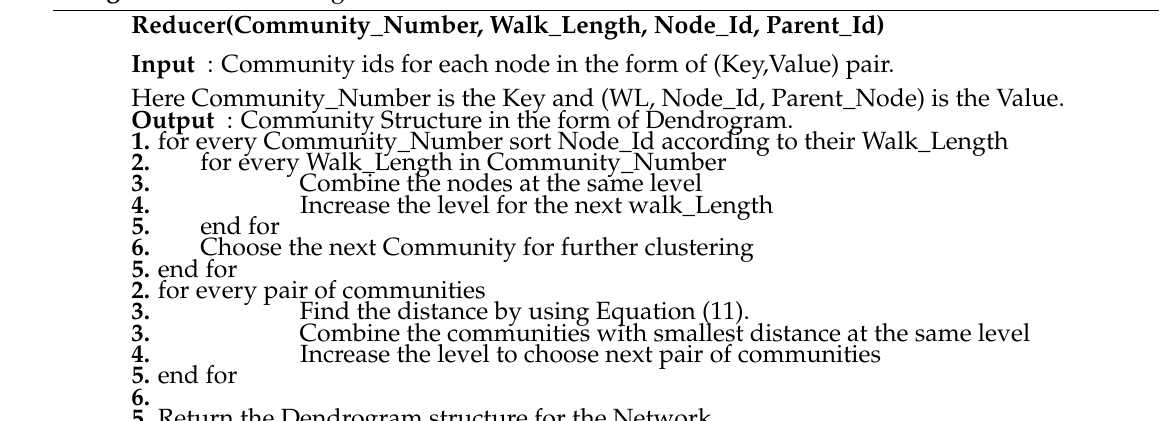
Algorithm 2: Clustering of detected